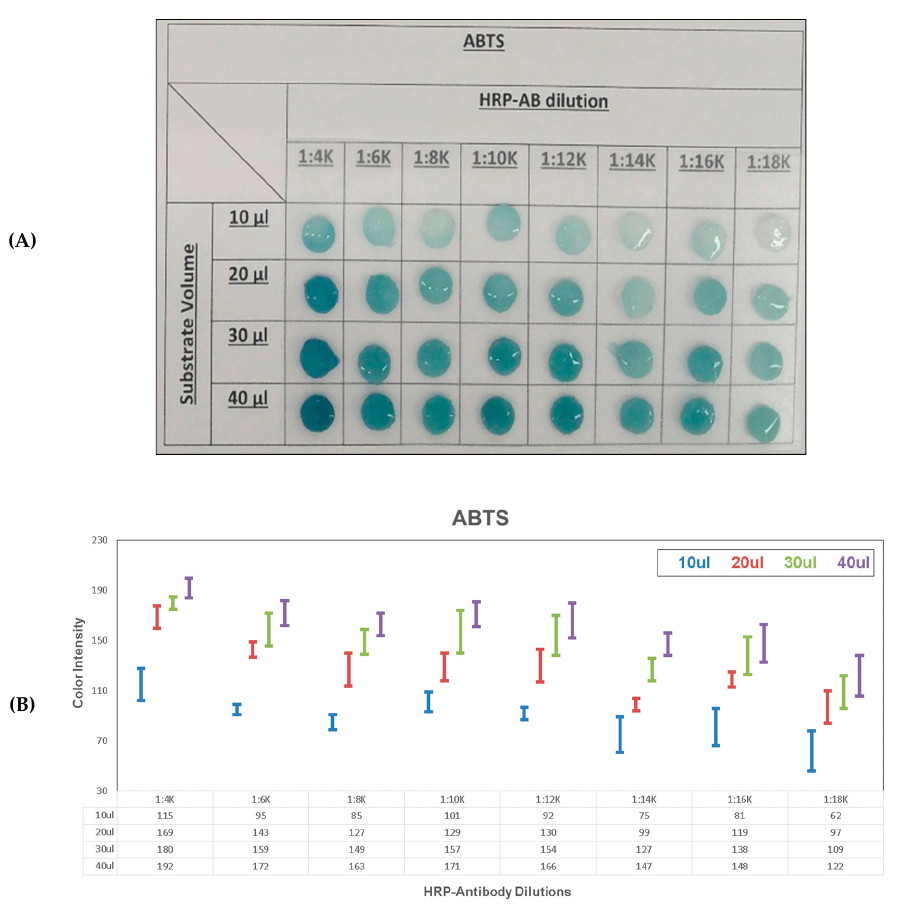
Figure 5. ABTS unstopped colorimetric signal on membrane. Colorimetric signal on membrane with a range of HRP-antibody concentrations and a range of ABTS substrate volumes: ( A ) picture and ( B ) color intensity analysis. Table 1. Color intensity analysis for TMB and ABTS unstopped colorimetric signal on membrane.